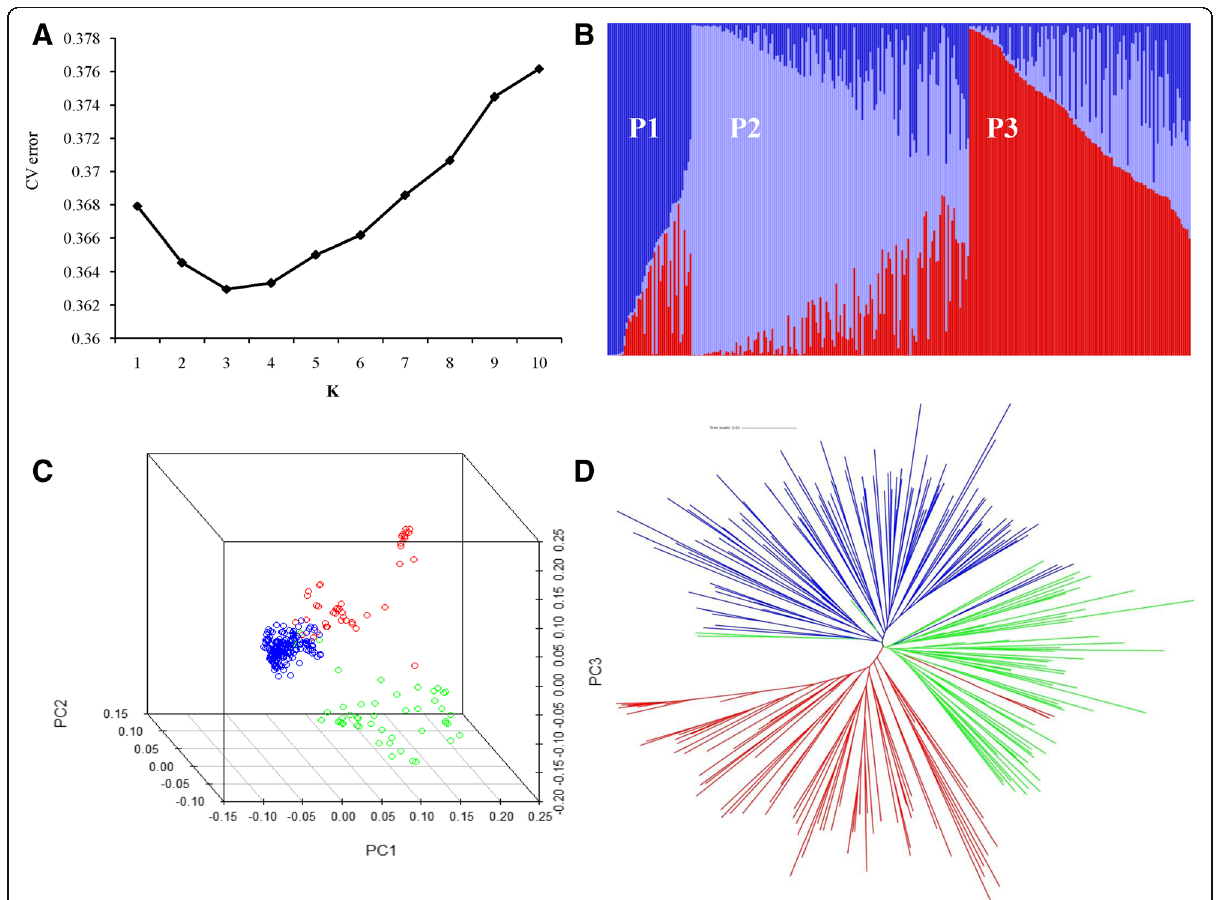
Fig. 2 Population structure of 295 japonica rice varieties. a , The CV error of each K value. b , Subgroups (K = 3) inferred using ADMIXTURE software. c , Principal component analysis of 295 japonica rice varieties. Colors of green, blue, and red represent P1, P2 and P3 in Fig. 2b, respectively. d , Neighbor-joining tree of 295 japonica rice varieties. Colors of green, blue, and red represent P1, P2 and P3 in Fig. 2b,